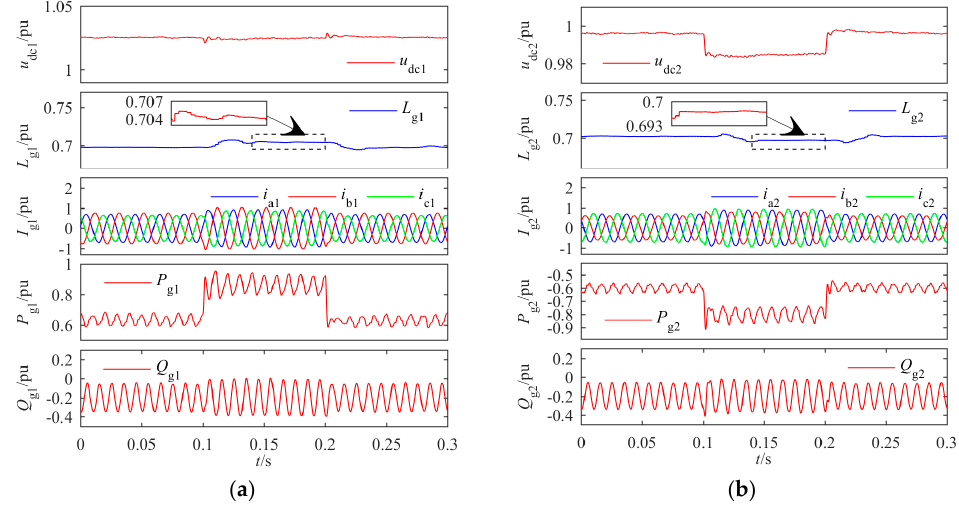
Figure 13. Responses of CS1 ( a ) and CS2 ( b ) to active power step changes under unbalanced grid voltage (UBGV) conditions for obtaining constant DC bus voltage.